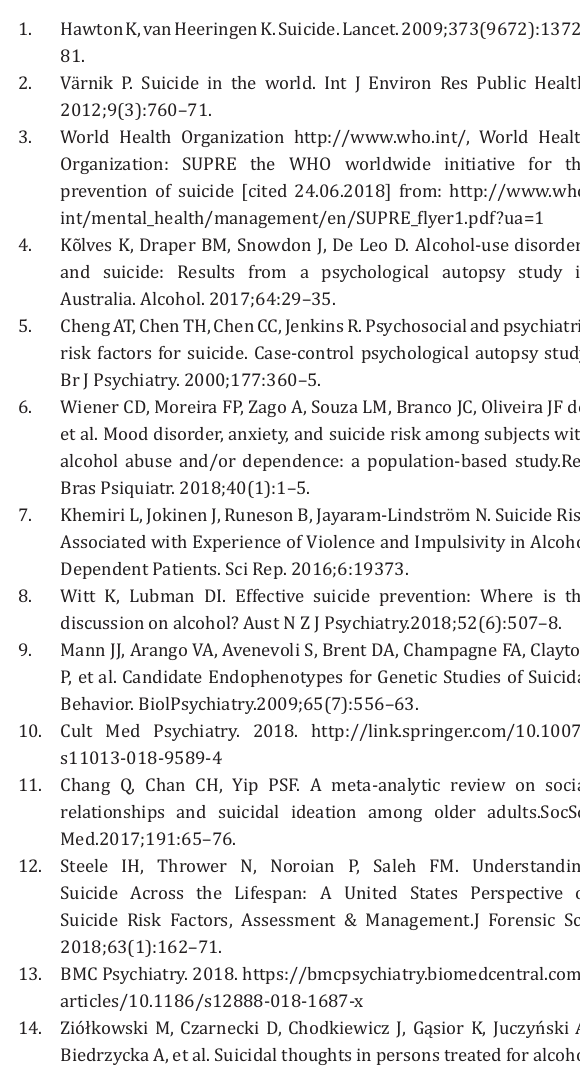
Comparison of selected clinical and personality variables in alcohol–dependent patients with or without a